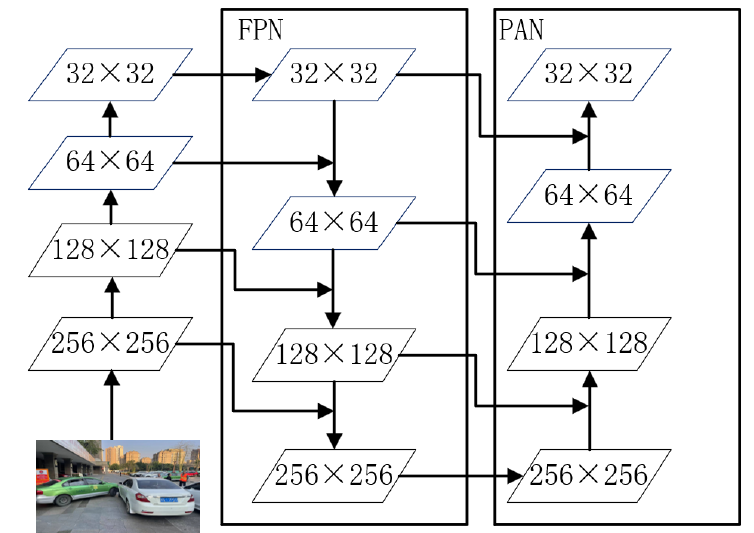
Figure 8. Improved PANet network